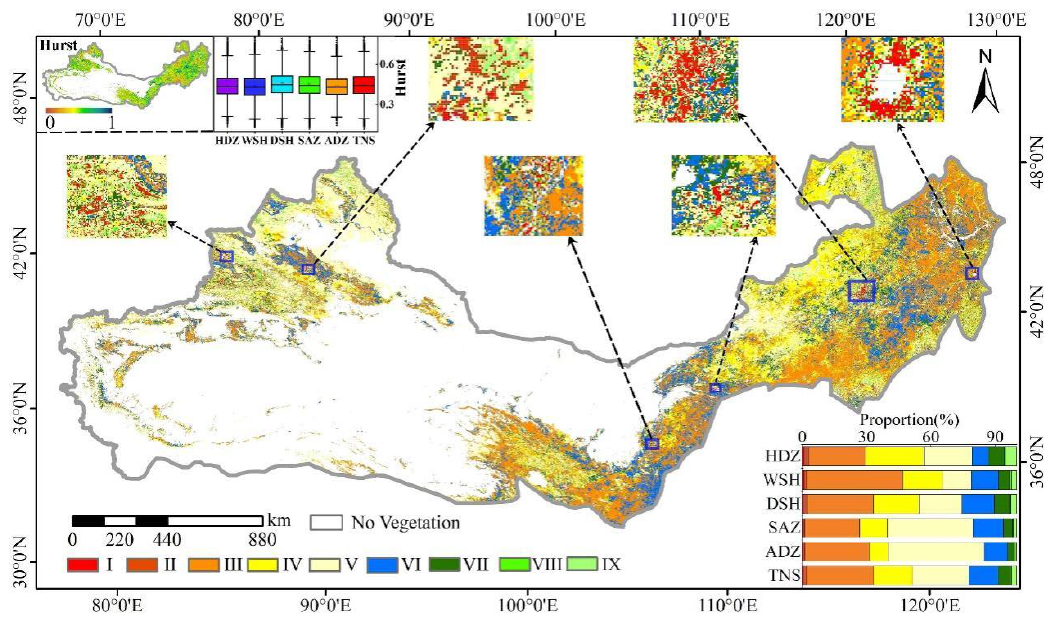
Figure 6. Future trends of VEQ in the TNS. (I-IX denote the different future trends shown in Table S2).